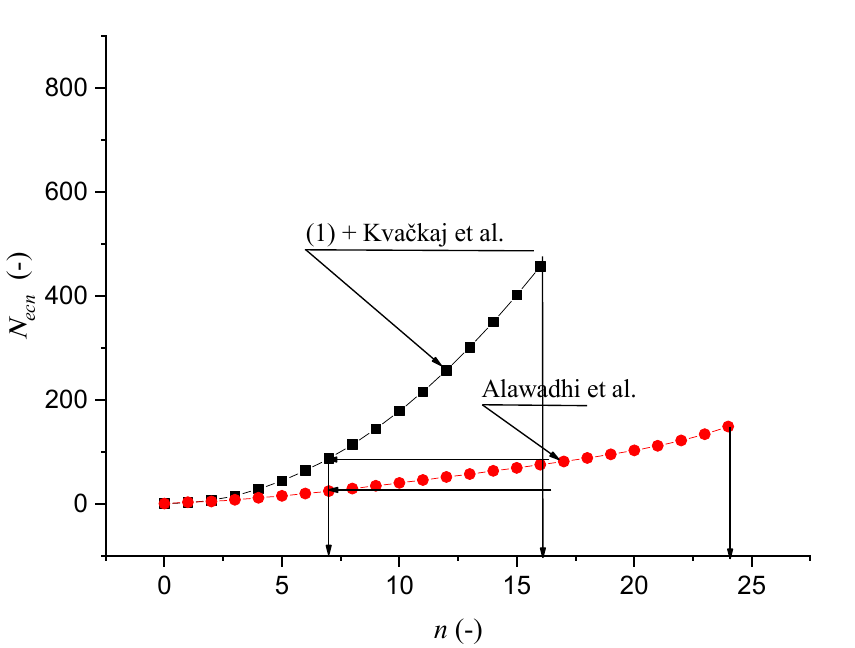
Figure 15. Comparison of the performances of equilibrium equation. The comparison of the left and right sides of the equation is declared in Figure 14. It is evident that for the left side, there is a smaller difference between the data up to 5% between the equilibrium Equation (1) and Kva č kaj. On the right side, there is a relative identity between these data.